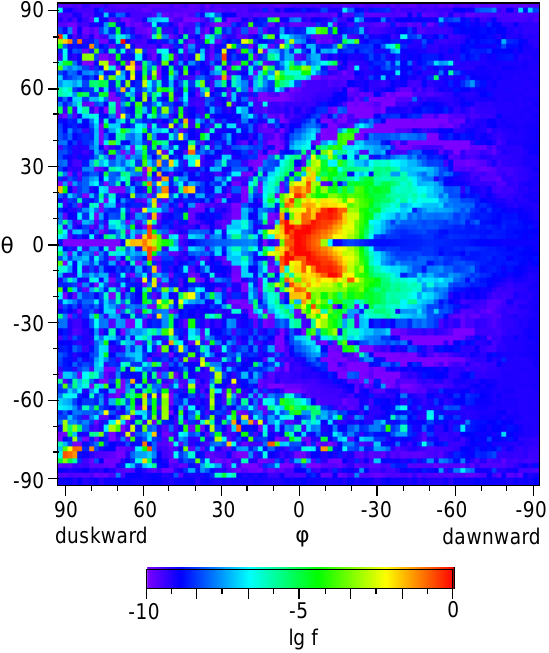
Fig. 7. Directional distribution of the phase space density in the velocity space φ,θ plane (viewed earthward with dusk to the left) at x =− 10 ,y = 5 ,z = 0 and t = 9min for earthward fluxes with v = 1 . 5 (corresponding to 180 keV). The f values are calculated using ini- tial kappa distributions (see